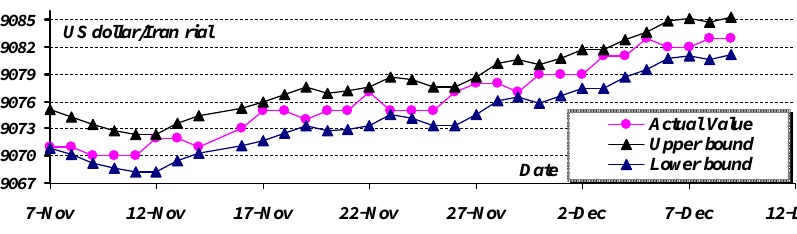
Fig. 6 Upper and lower bounds obtained for US dollar against Iran rial (after deleting).